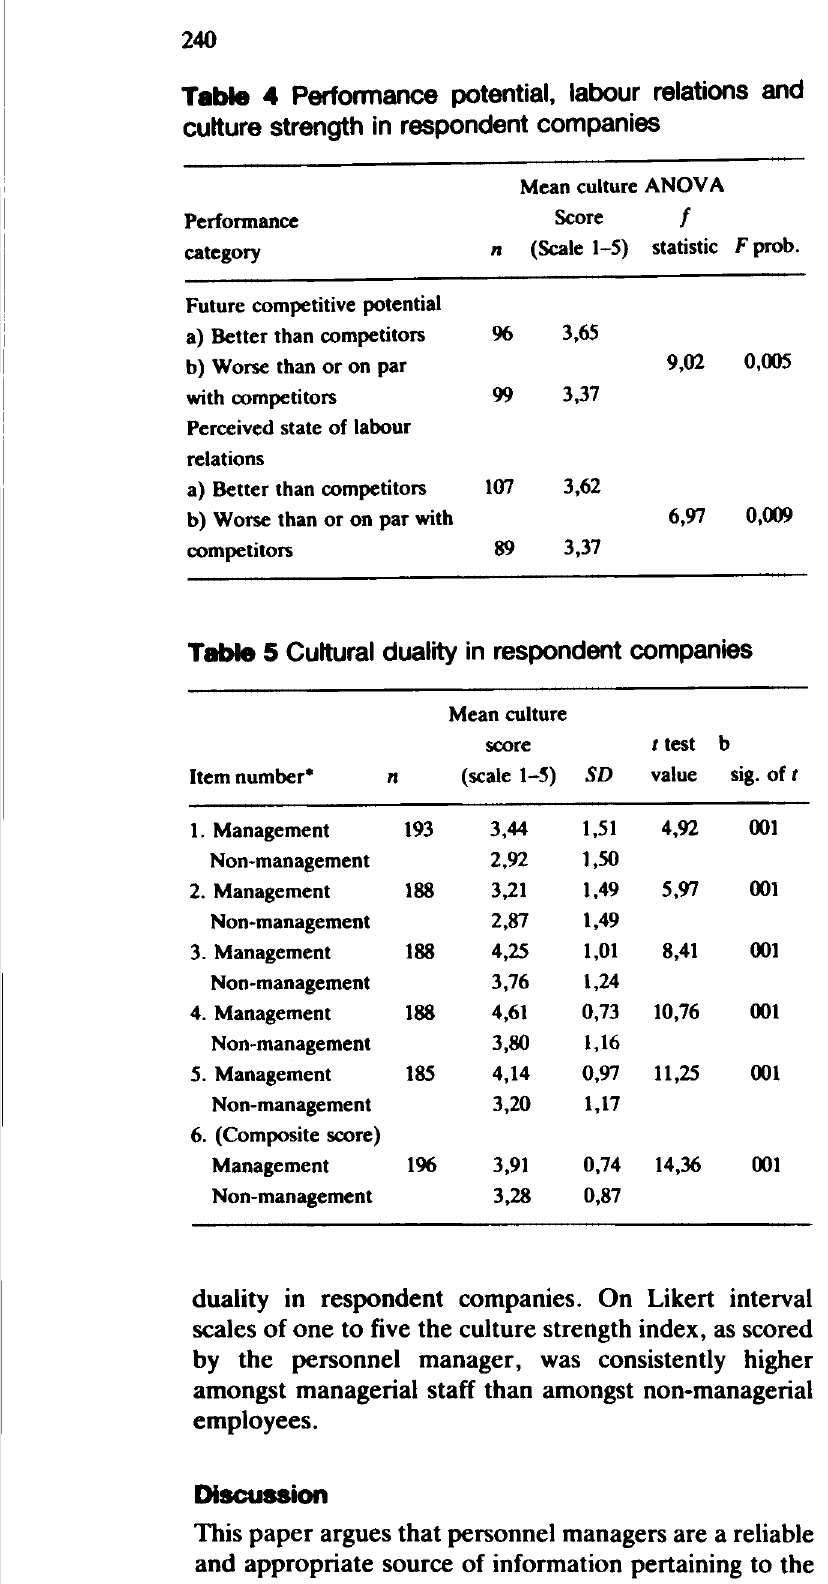
Table 4 Perfonnance potential, labour relations and culture strength in respondent companies